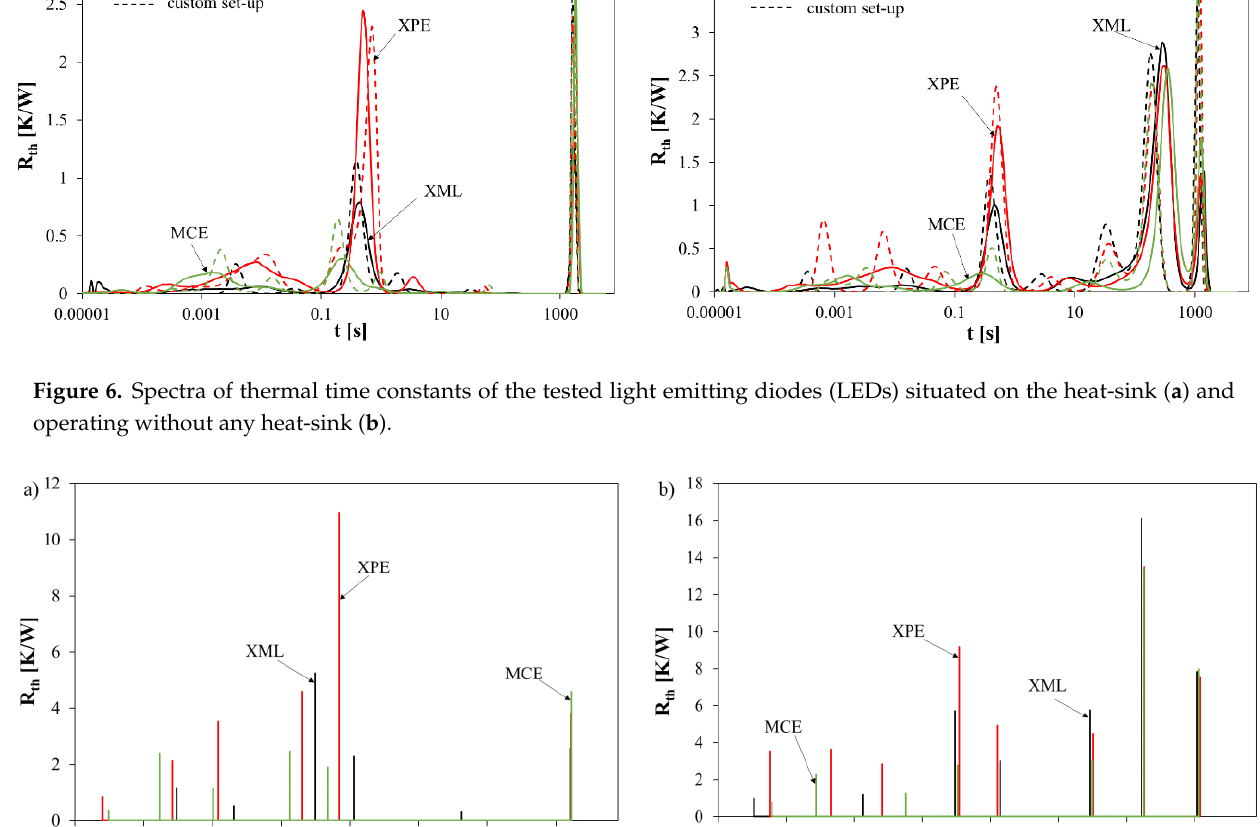
Energies 2021 , 14 , x FOR PEER REVIEW 10 of 14